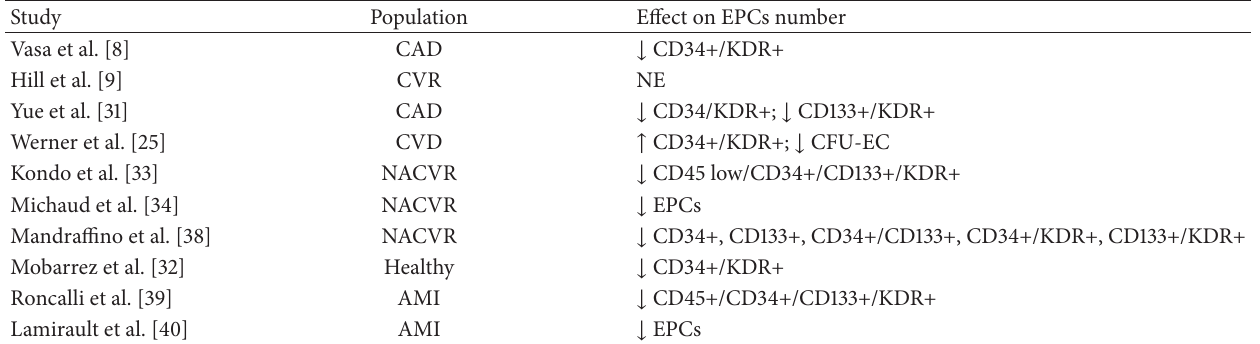
Table 1: Smoking and EPCs.